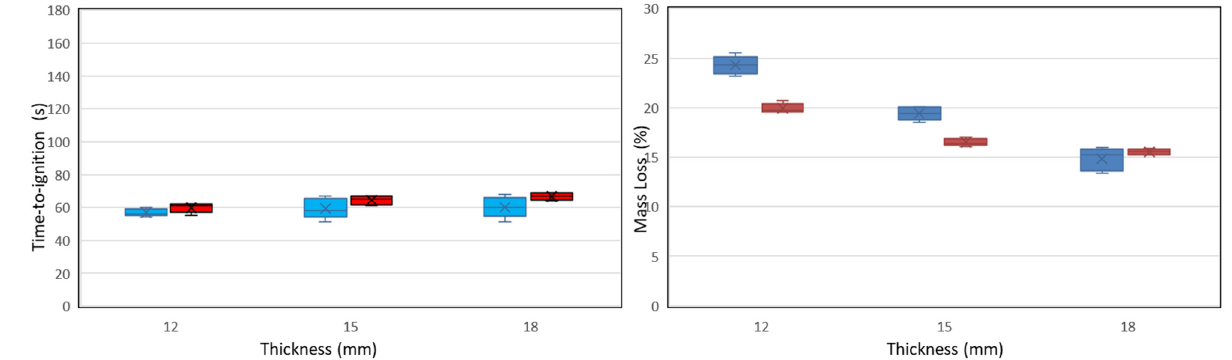
Figure 6. Graphical representation of time-to-ignition and mass loss dependence on board thickness and heat flux with box plots. Legends: blue colour is marked for OSB samples, PB is marked by red, lineárny OSB is linear OSB curve and Lineárny PB is linear curve of PB. Confidential interval 95%.